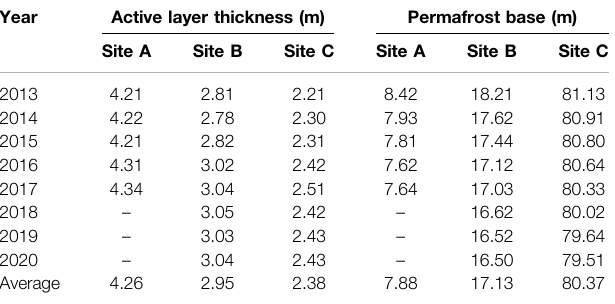
TABLE3| Thicknessoftheactivelayerandthebaseofthepermafrostatthethree sites (Site A, Site B, and Site C) from 2013 to 2020. Due to the disappearance of permafrost at site A from 2018, neither the thiclness of the active layer or the depthofthepermafrostbaseareavailablefortheperiod2018to2020inthetable. Year Active layer thickness